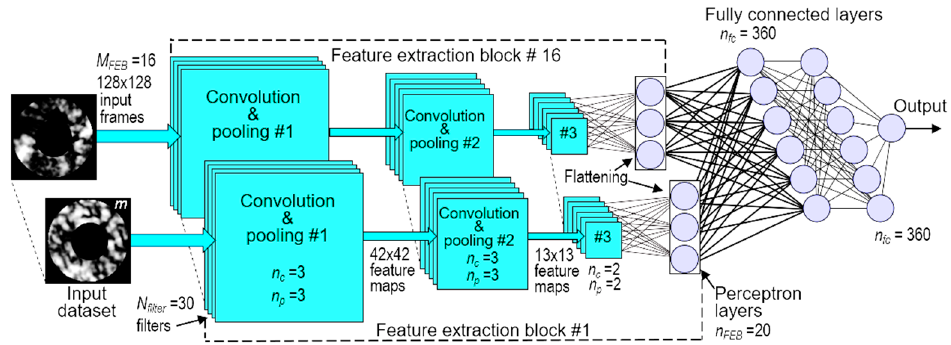
C prediction via processing of scintillation n